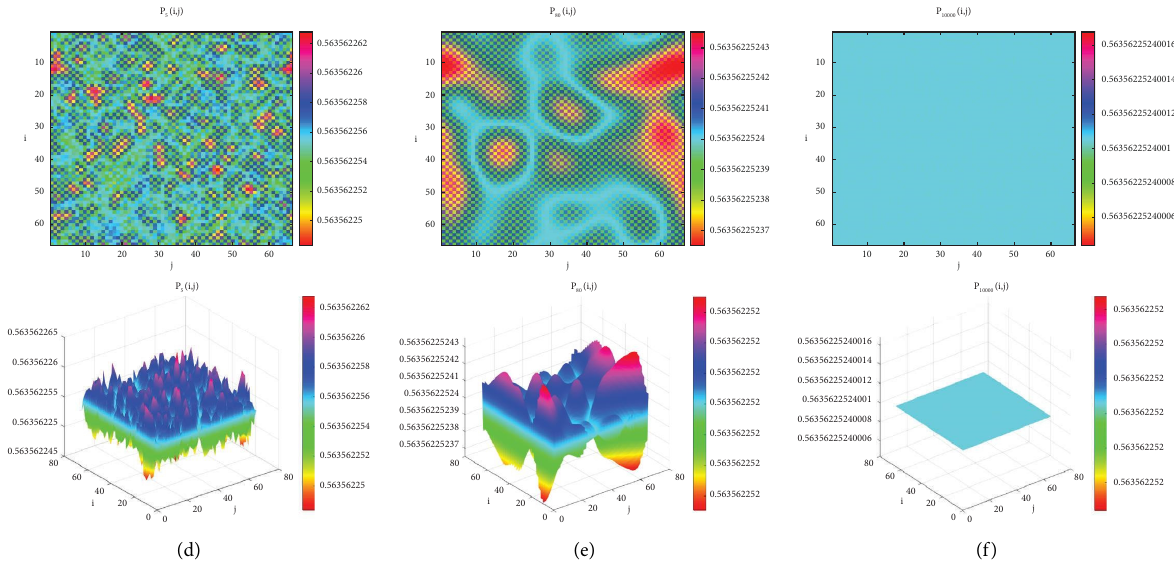
� 0 . 2, ( d , σ ) � ( 0 . 175 , 0 . 75 ) falls in the region I of Figure 8(b), which is consistent with 1 2